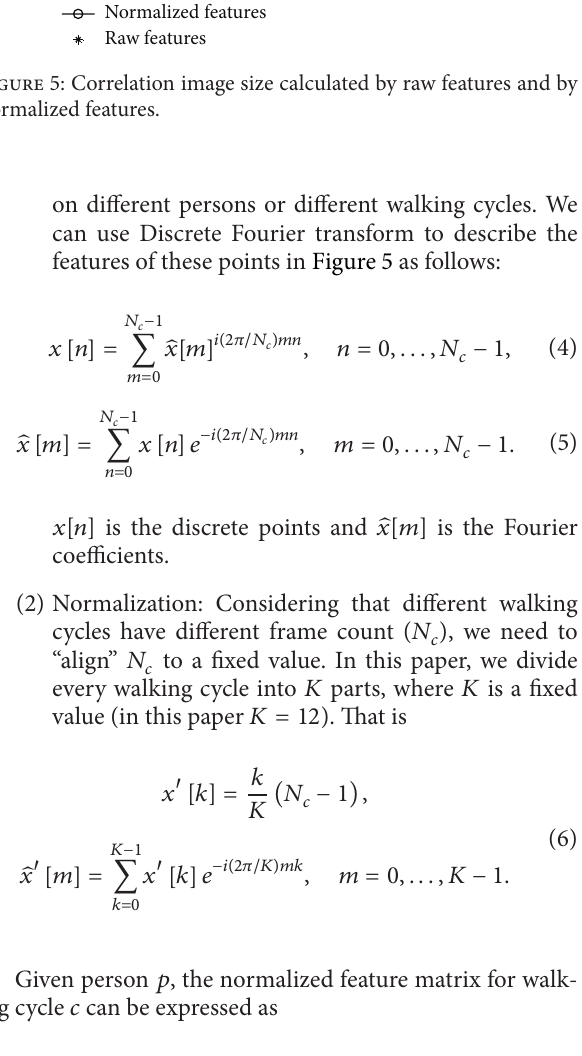
Figure 3: (a) An image whose frame index is 𝑡 . (b) An image whose frame index is 𝑡 + 1 . (c) The image expression of correlation result (the bright area) of image 𝑡 and image 𝑡 + 1 , 𝑆 𝑖 = (0, 5, 1) .